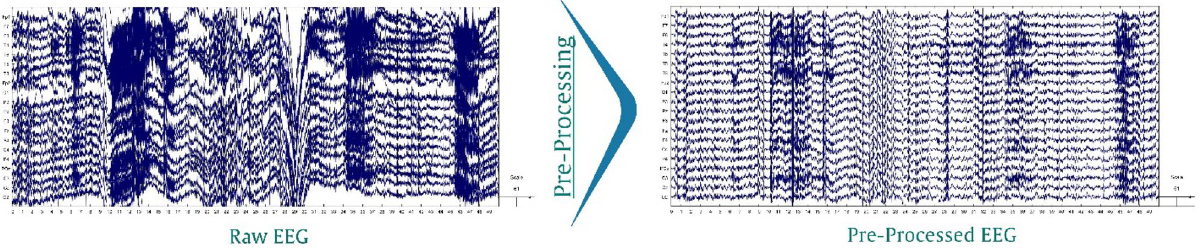
Figure 2. An example of the result of EEG pre-processing steps for 50 s (the x-axis shows time in seconds, and the y-axis shows voltage in units of Feature extraction. The feature extraction step was performed using power spectral density (PSD) and log